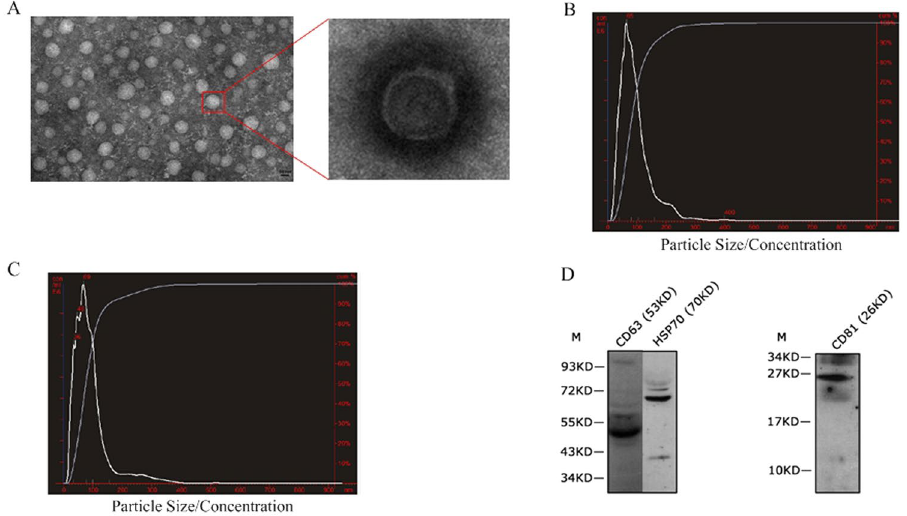
Figure 1. Isolation and identification of exosomes from C. semilaevis serum. ( A ) Electron microscope images of exosomes; ( B ) Particle size distributions and concentration of exosomes in males analyzed by NTA; ( C ) Particle size distributions and concentration of exosomes in females analyzed by NTA; ( D ) Identification of CD63, HSP70 and CD81 by Western